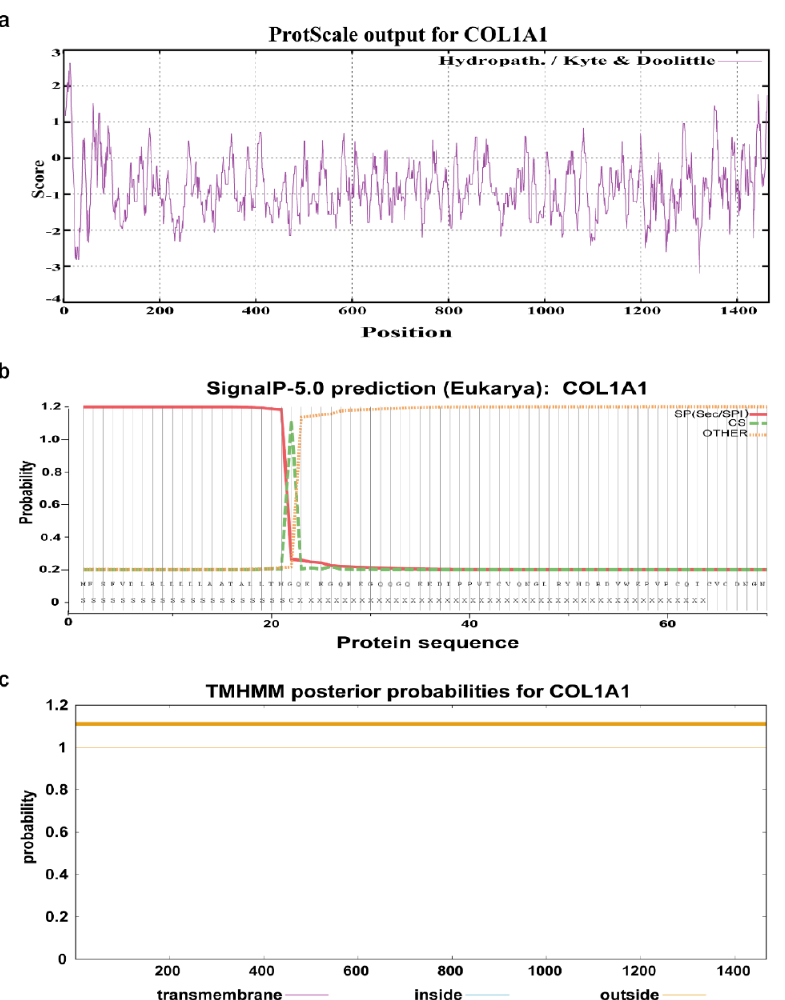
Figure 5. Amino acid sequence analysis of porcine COL1A1. ( a ) Hydrophilicity or hydrophobicity prediction of porcine COL1A1; ( b ) Signal peptide prediction of porcine COL1A1; ( c ) Transmembrane domain prediction of porcine COL1A1.